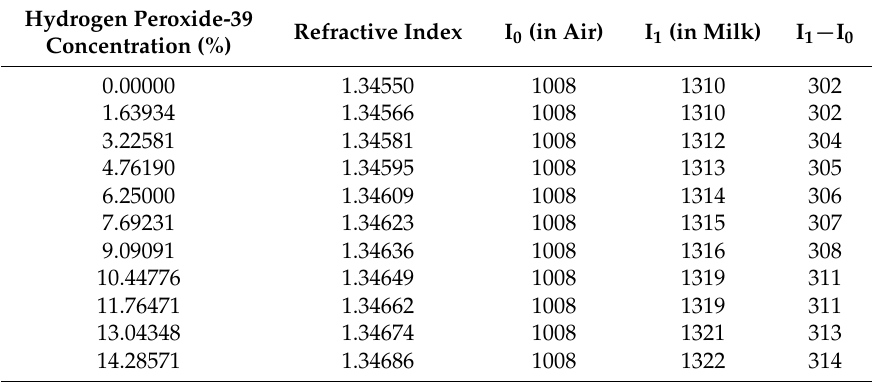
Table 3. Sensor readouts with probe P-233 for hydrogen peroxide-39.